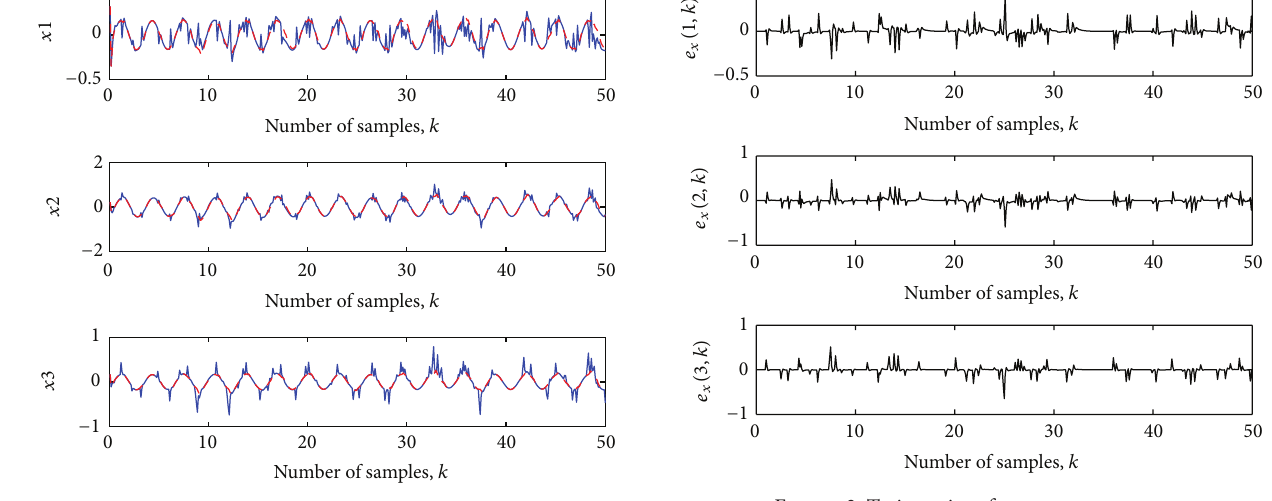
Figure 1: Trajectories of system states and observed value. Figure 2: Trajectories of system states error.